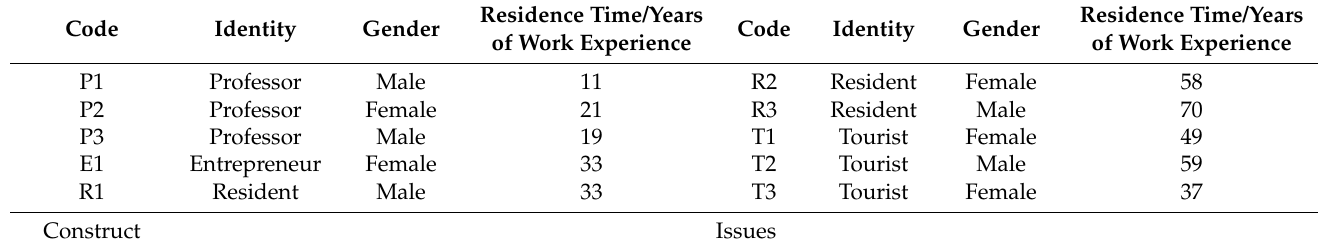
Table 4. Respondent’s background information and an overview of the interview